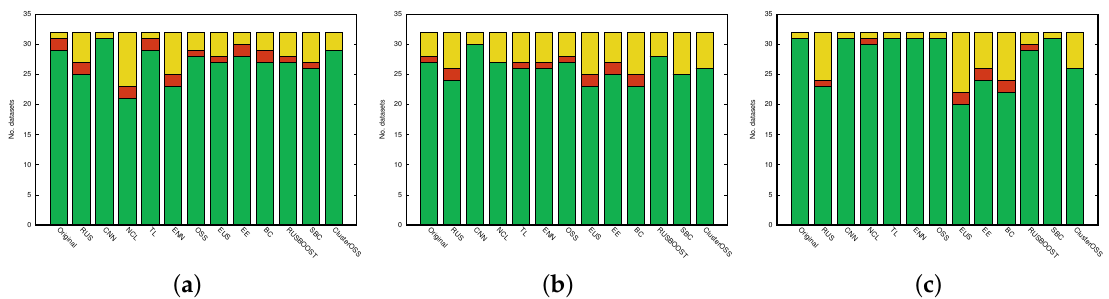
Figure 8. Comparison of DBMIST-US with reference methods with respect to the number of data sets on which DBMIST-US was statistically significantly better (green), equal (yellow), or worse (red). ( a ) 1NN; ( b ) J48; ( c ) SVM.